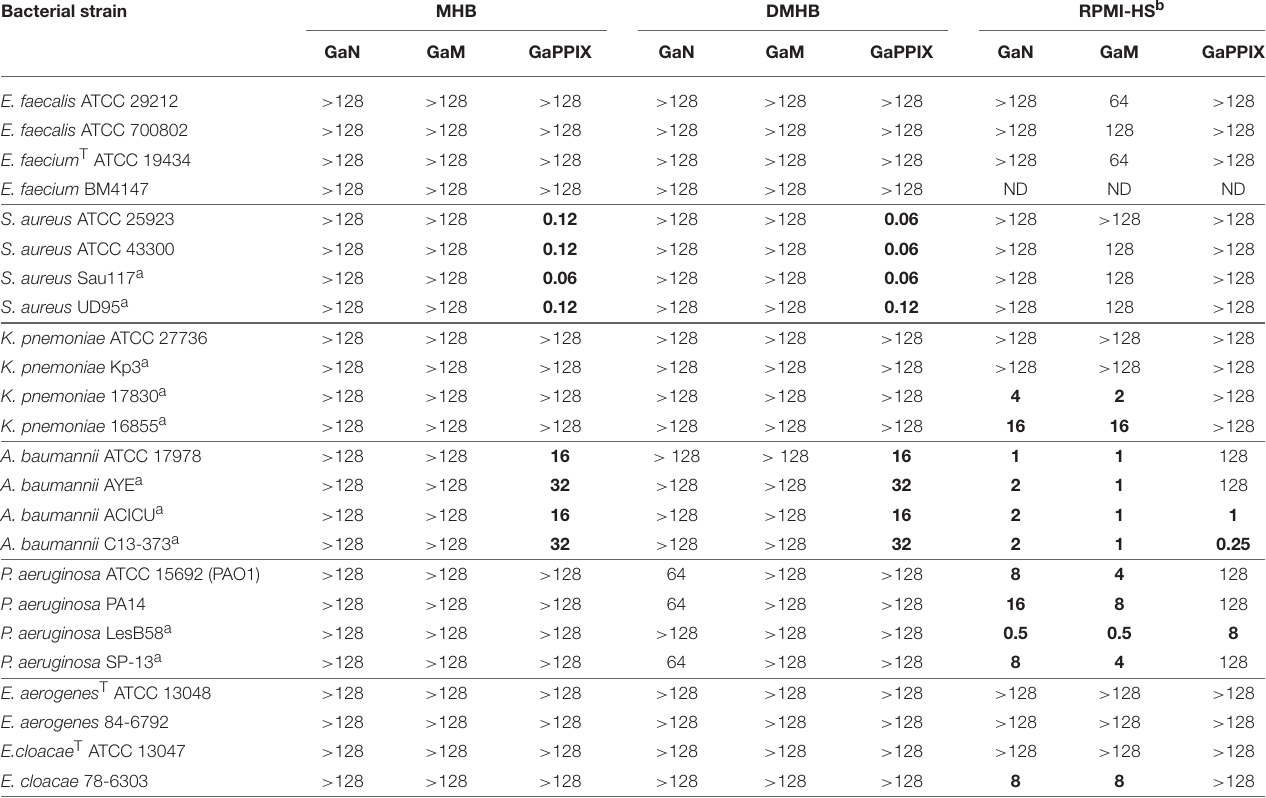
TABLE 1 | MIC ( µ M) of Ga(III) compounds for ESKAPE strains. Bacterial